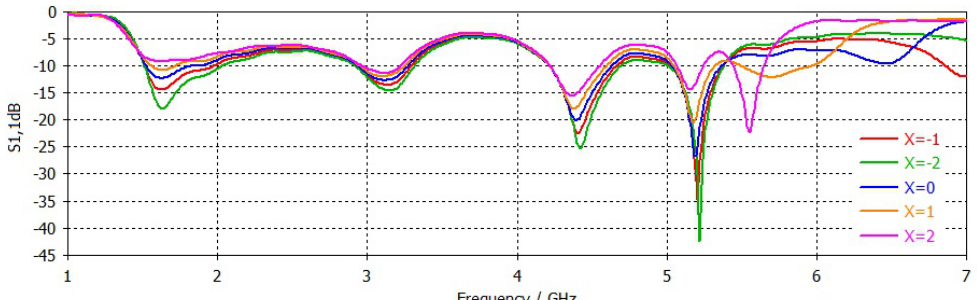
Figure 3. The simulated input reflection coefficient of the antenna with different values of feed line length ( L f +X ).